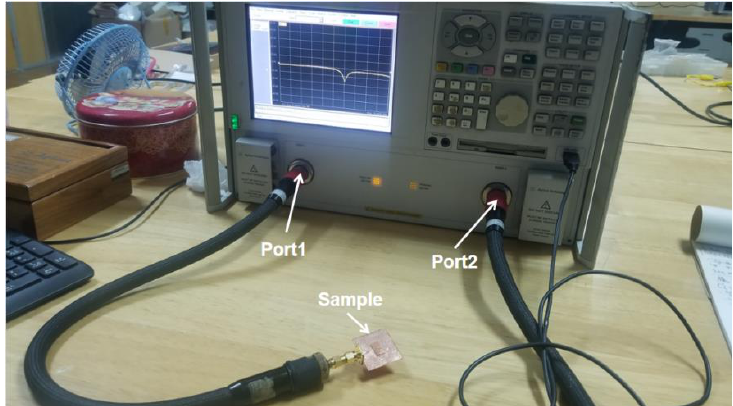
Figure 5. The measurement setup for antenna reflection coefficients.